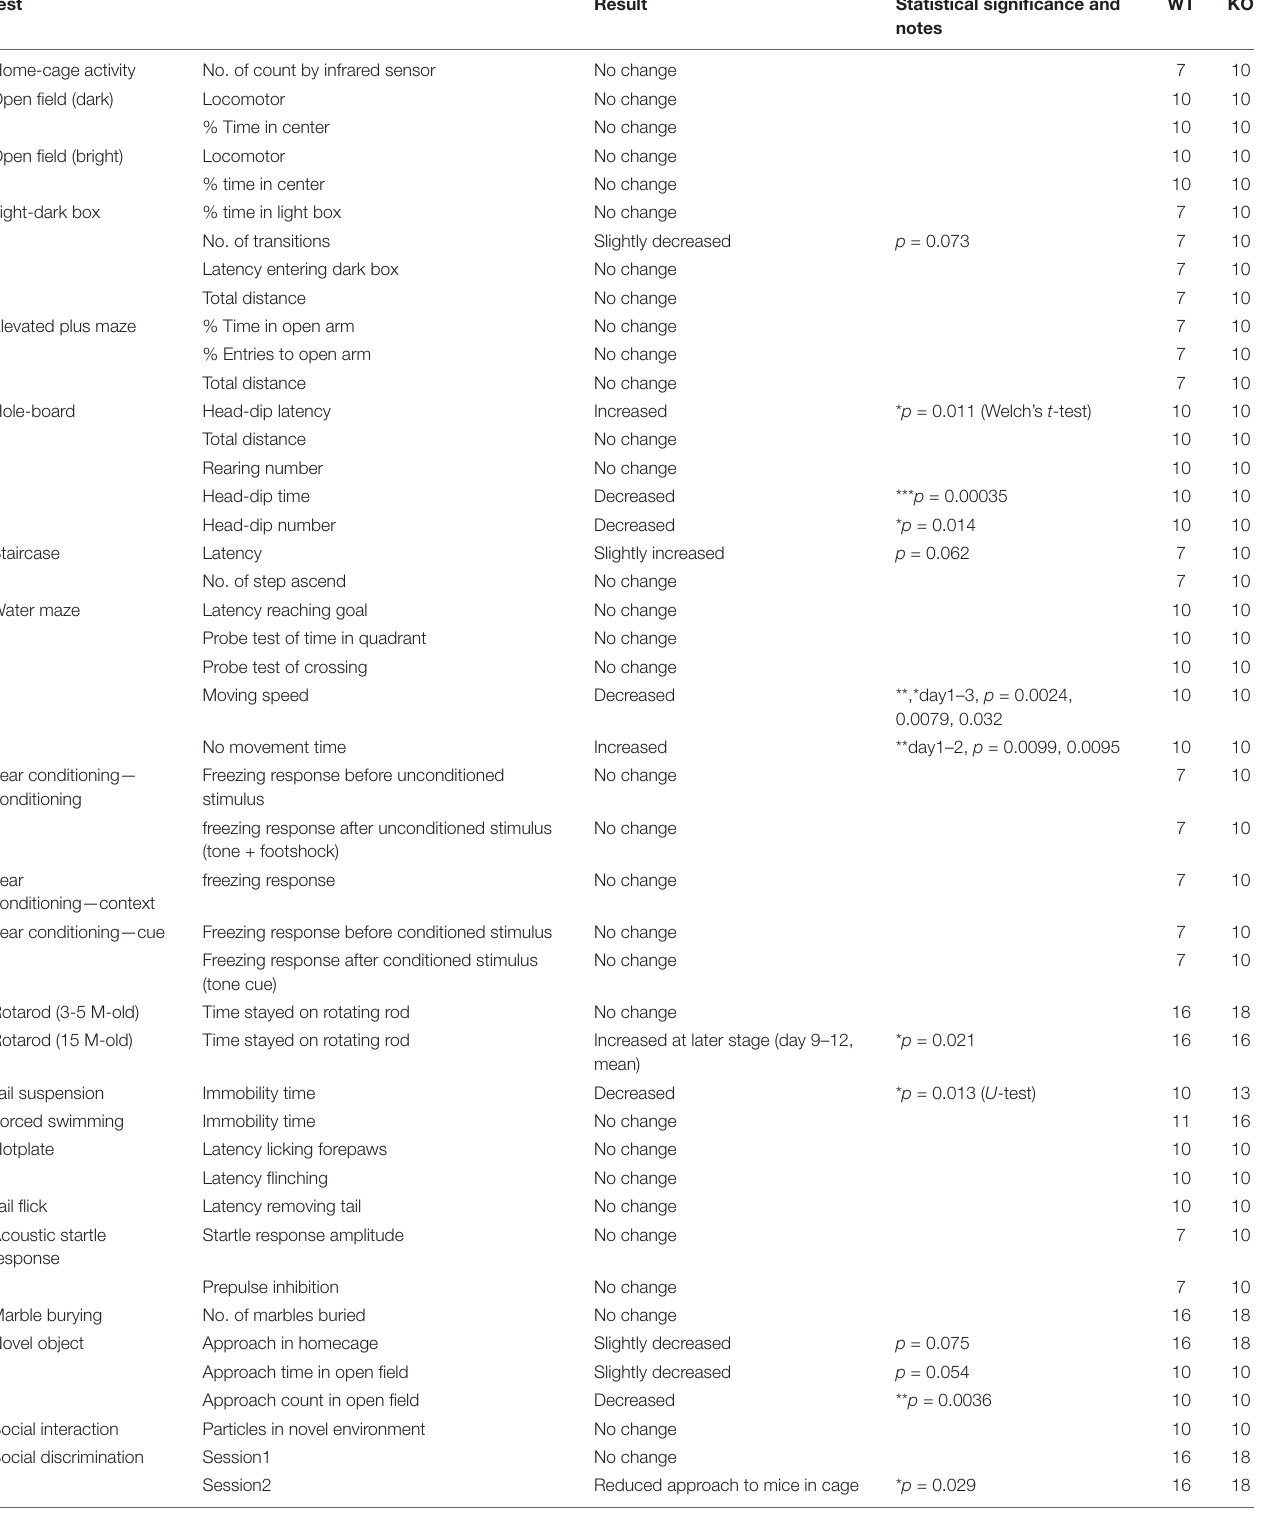
TABLE 2 | Summary of Lrtm2 KO behavioral